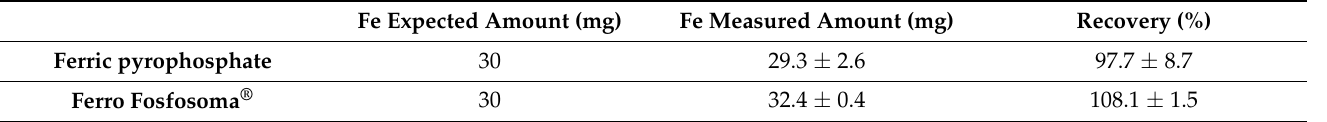
Table 3. Percentage of Fe recovery of tested formulations at the end of in vitro digestive process. Results are expressed as mean ± standard deviation.